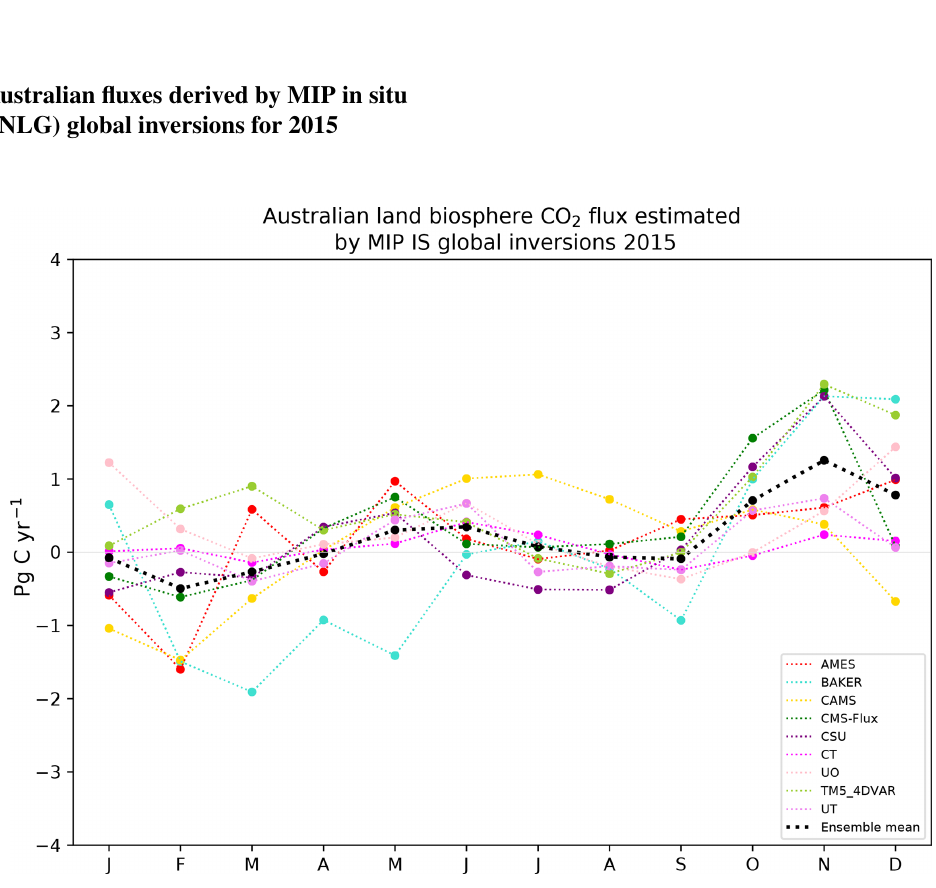
Figure I1. Time series of monthly mean carbon fluxes derived by MIP in situ (IS) global inversion for 2015.